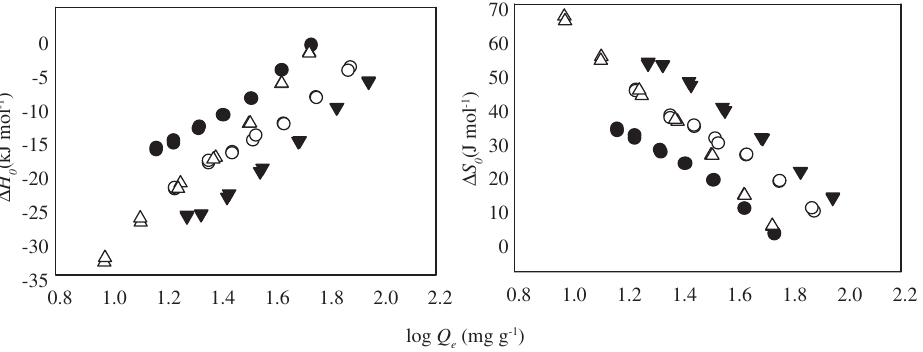
Figure 5: Plots of standard enthalpy change ( Δ H 0 ) and standard entropy change ( Δ S 0 ) of methylene blue adsorption on multi-walled carbon nanotubes (MWCNTs). Symbols (● and ○) and ( ▾ and Δ ) represent MWCNTs and oxidized MWCNTs (MWCNTs-Ox). Closed and open symbols represent temperatures 298 K and 318 K, respectively.